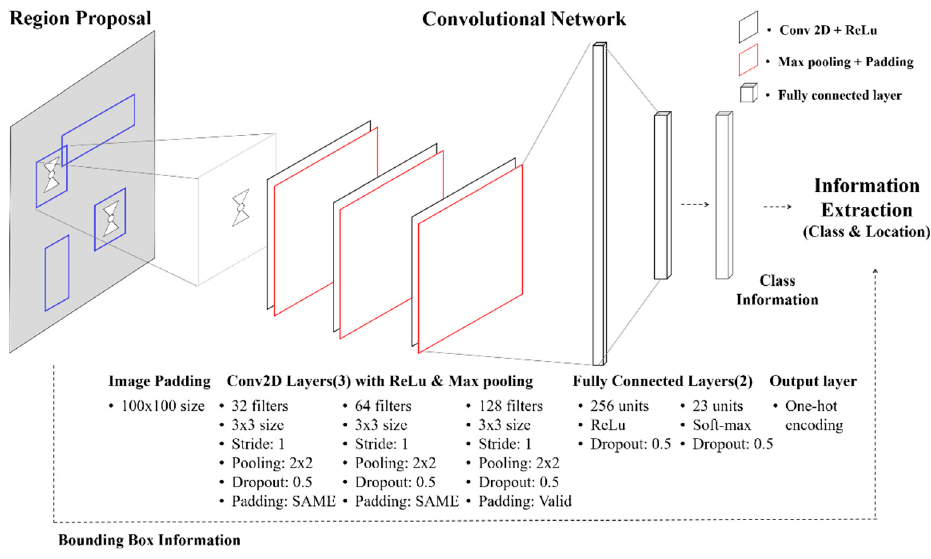
Figure 6. R-CNN scheme for symbol recognition of P&ID.